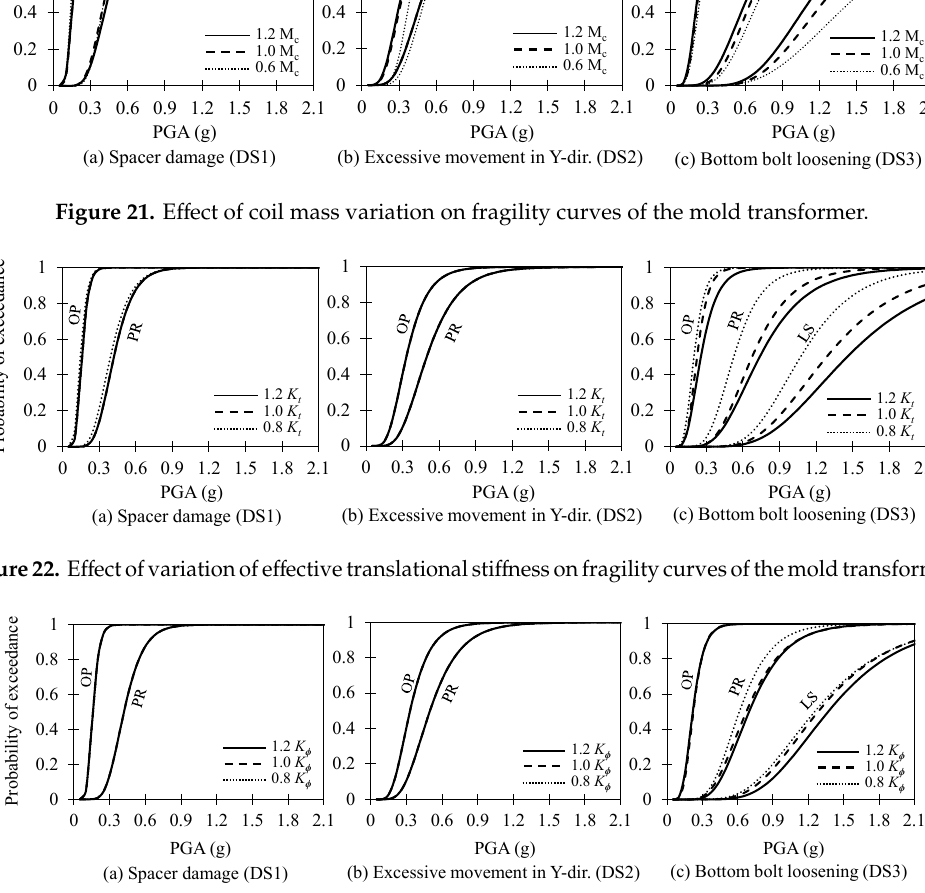
Figure 23. E ff ect of variation of e ff ective rotational sti ff ness on fragility curves of the mold Figure 23. Effect of variation of effective rotational stiffness on fragility curves of the mold transformer. Figure 23. Effect of variation of effective rotational stiffness on fragility curves of the mold Figure 23. Effect of variation of effective rotational stiffness on fragility curves of the mold transformer. transformer.